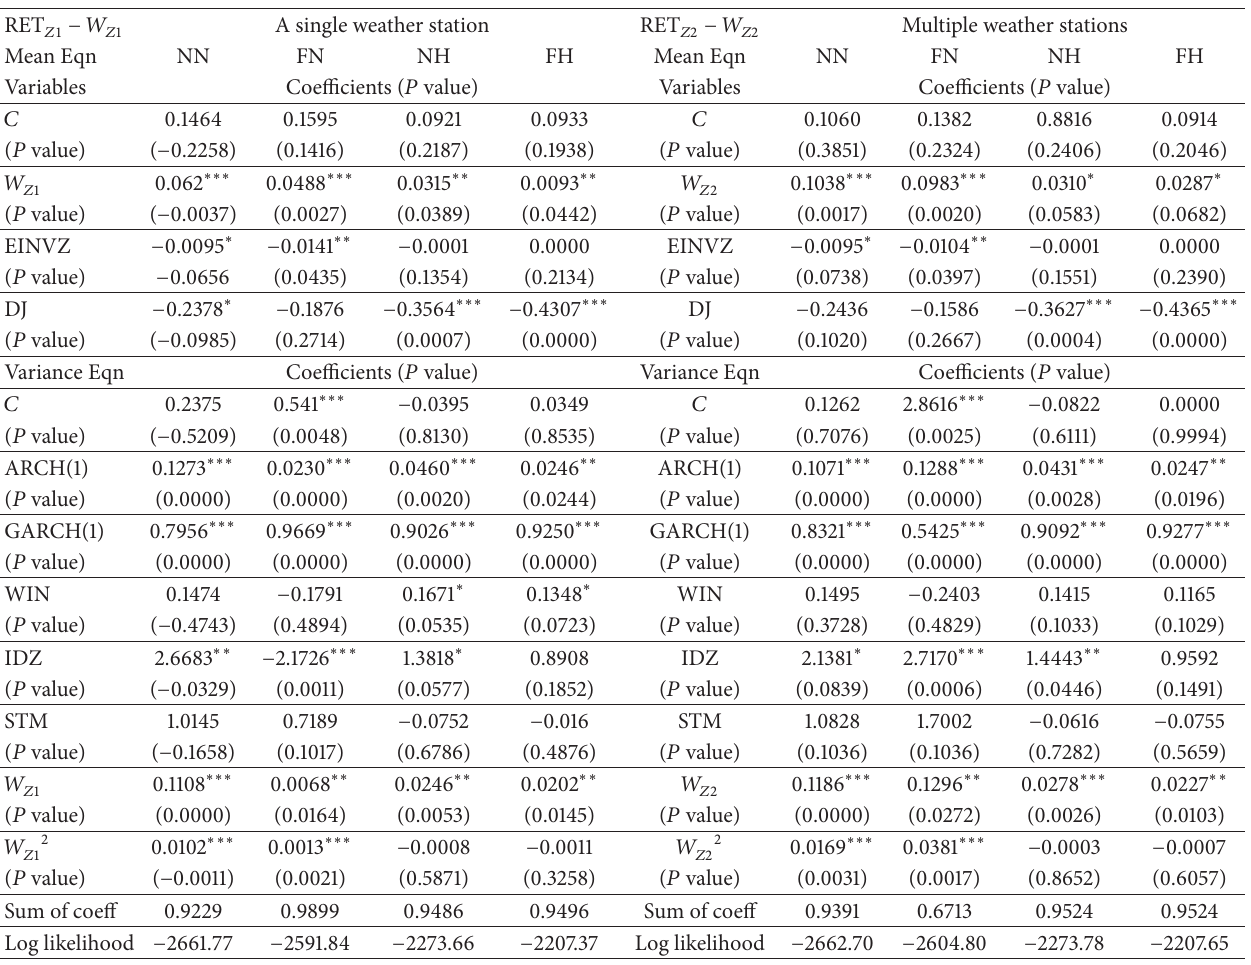
Table 4: Summary of the near-month and far-month energy futures